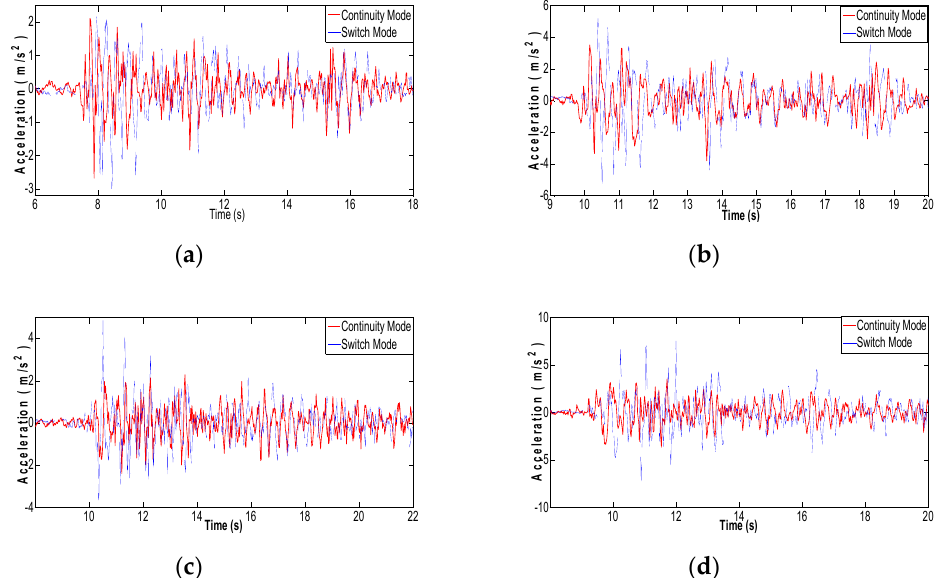
Figure 13. The displacement response of isolation layer. ( a ) El Centro earthquake—0.36 g; ( b ) El Centro earthquake—0.72 g; ( c ) Taft earthquake—0.36 g; ( d ) Taft earthquake—0.72 g.